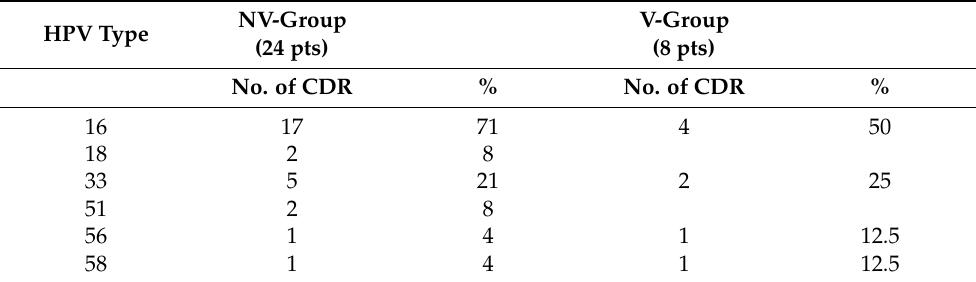
Table 3. HPV types of distribution identified at clinical disease recurrence.